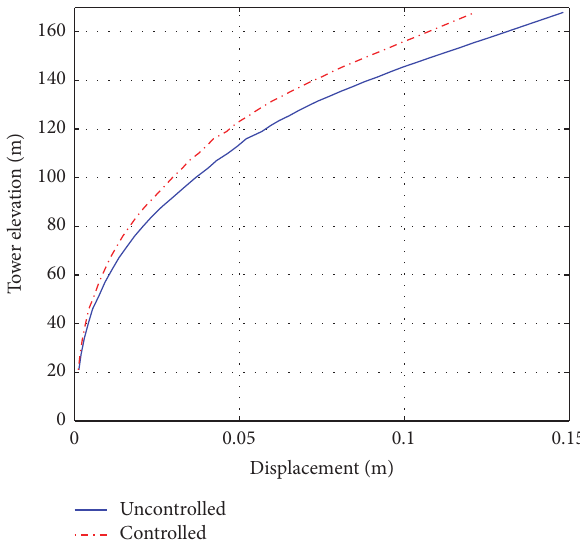
Figure 10: Displacement control result of total tower under wind